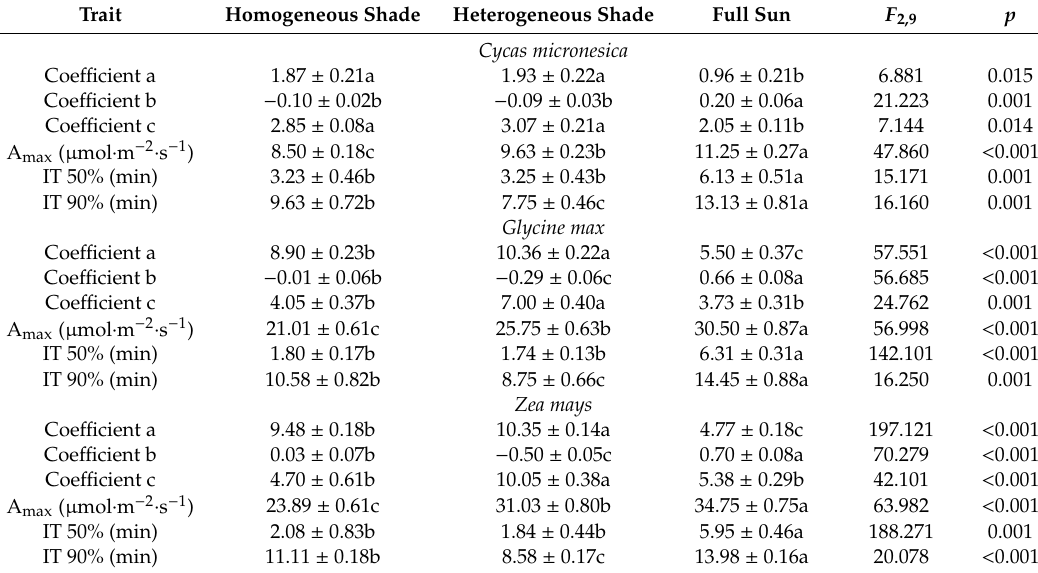
Means followed by the same letter within rows are not significantly di ff erent according to Tukey’s honest significant di ff erence